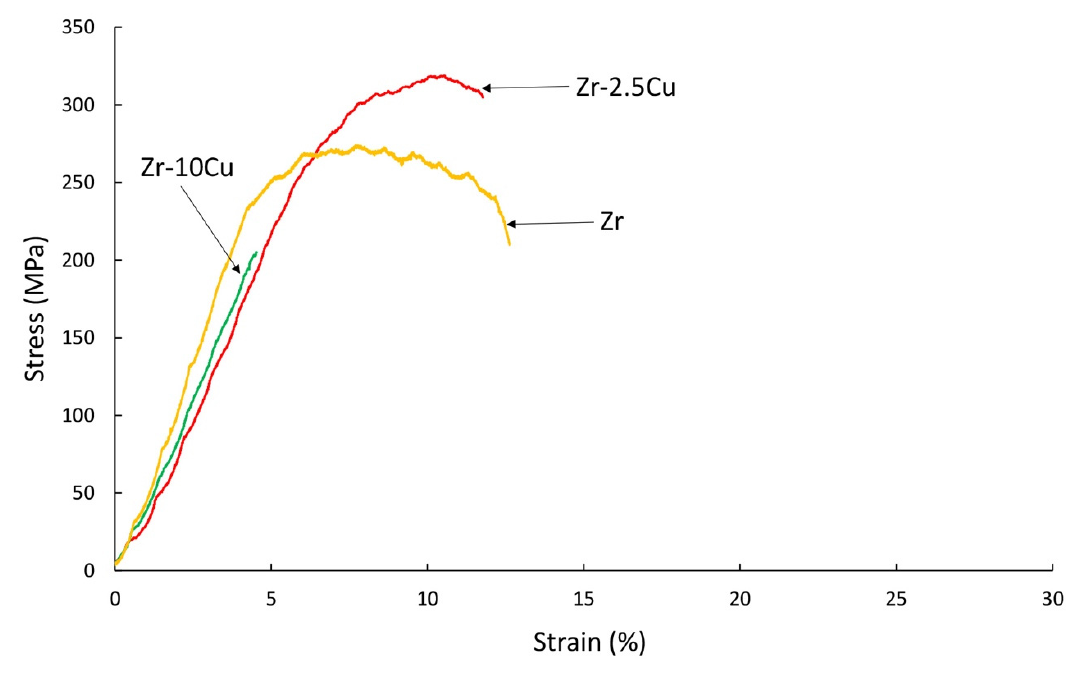
Figure 13. Tensile behavior of the sintered samples (SPS) of Zr-2.5Cu and Zr-10Cu at 400